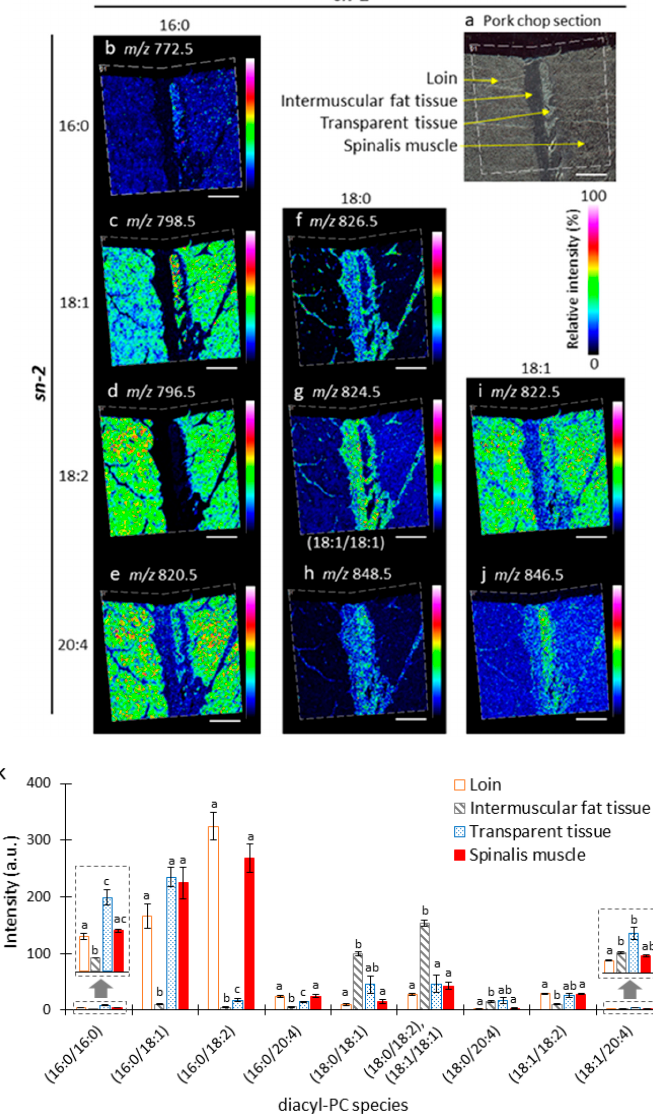
Figure 4. MALDI–MSI analysis of diacyl-phosphatidylcholine (PC) species in pork chop sections. ( a ) Optical image of pork chop section prior to MALDI–MSI analysis. ( b – j ) Representative ion images arranged according to their fatty acid compositions. Fatty acid compositions at the sn-1 position are arranged along the x-axis, and those at the sn-2 position are arranged along the y-axis. Scale bar represents 2 mm. ( k ) Intensities of diacyl-PC species in longissimus thoracis et lumborum muscle (loin), intermuscular fat tissue, transparent tissue, and spinalis muscle using MALDI-MSI. The data are expressed as the mean ± standard deviation ( n = 3). Mean values with different letters indicate significant differences ( p < 0.05) as determined by Dunnett’s T3 multiple comparisons test.